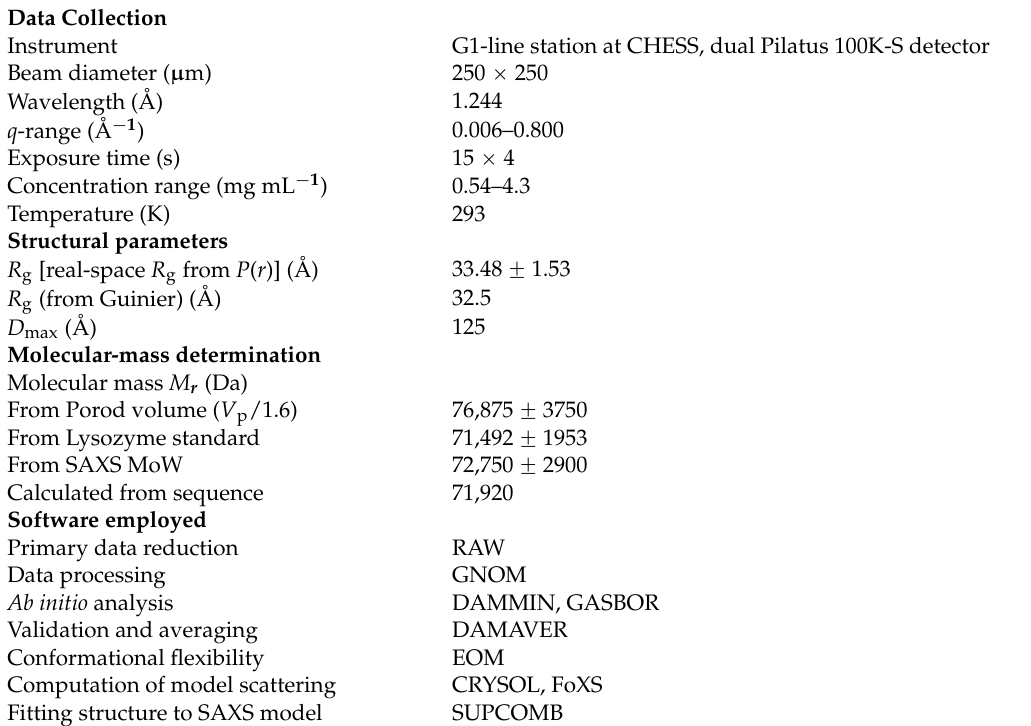
Table 2. Small-angle X-ray scattering (SAXS) data analysis for 3CD